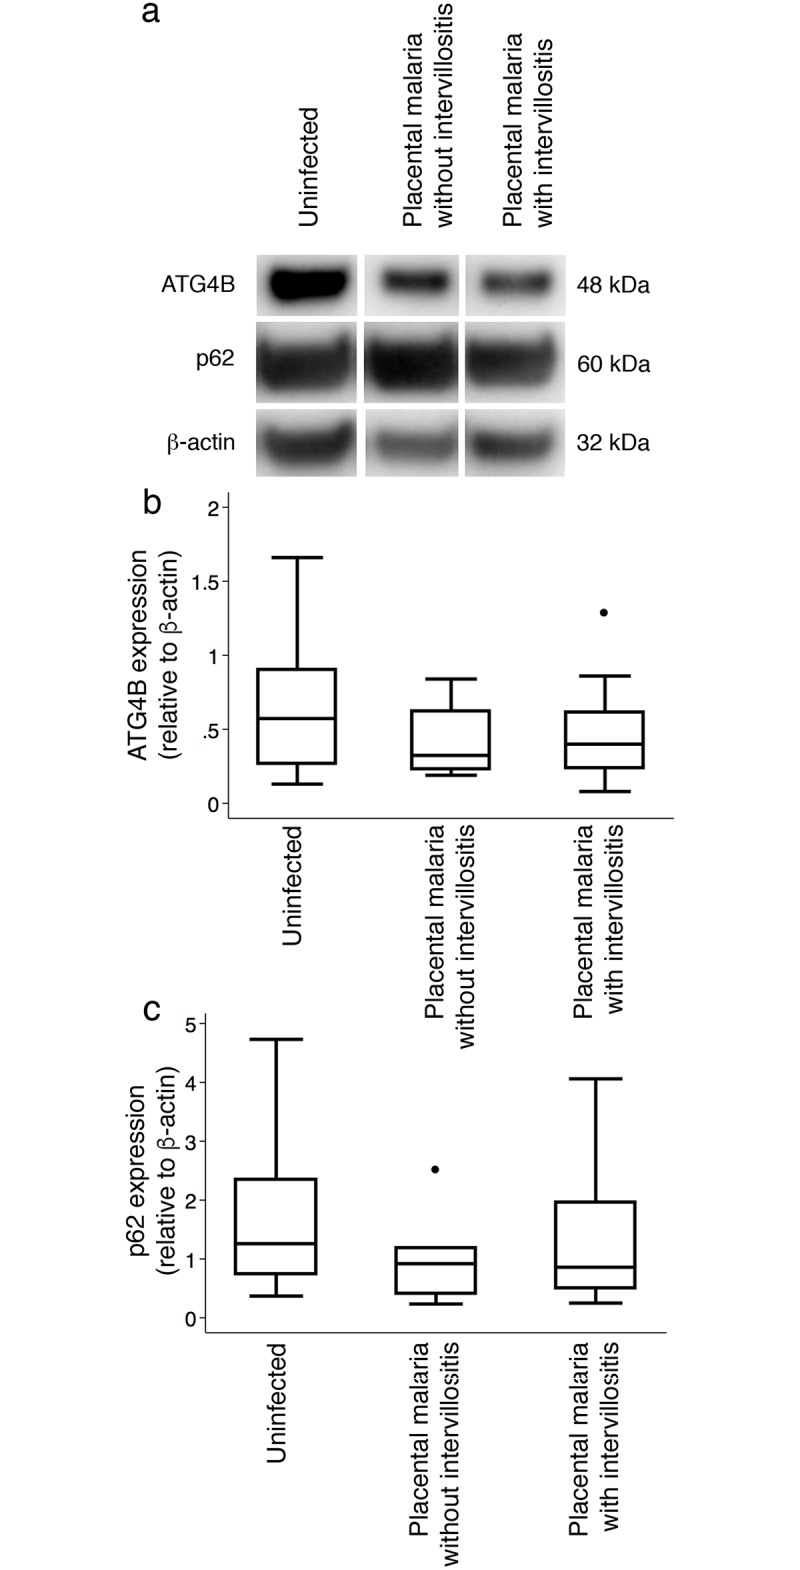
Expression of ATG4B and p62 in placental homogenates.(A) Representative western blots of uninfected, placental malaria without intervillositis (PM without IV) and placental malaria with intervillositis (PM with IV). (B) ATG4B and (C) p62 expression (relative to β-actin) were compared between uninfected placentas (n = 17) and infected placentas without (n = 7) or with (n = 14) intervillositis. Bars represent median, 25th and 75th percentiles, the whiskers are 5th and 95th percentiles and the dots are outliers.